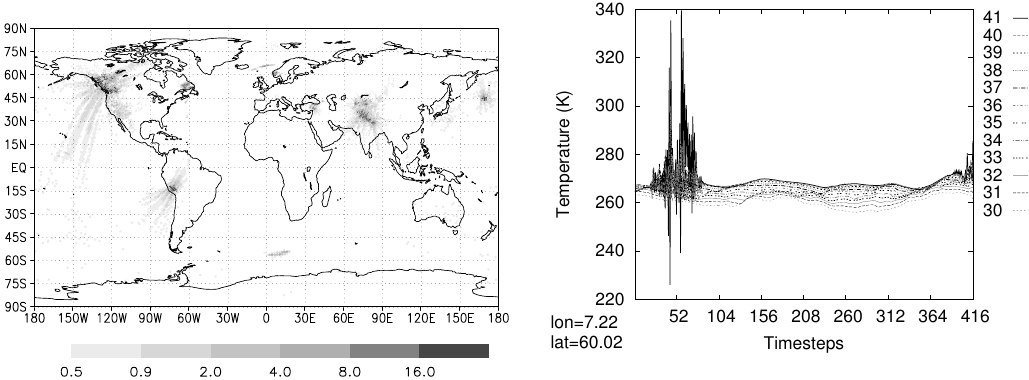
Fig. 12. The left figure shows the amplitude of 2∆ t temperature oscillations on the lowest model level (in Kelvin) after 96 hour forecast computed according to Equation 9 for the model run with the fibrillation amplifi- cation test of the large scale precipitation scheme but with evaporation ratio of ice and water reduced to 8. The figure on the right shows temperature (in Kelvin) in one model point on the 12 lowest model levels for each time-step during the 96 hour forecast for the model run with the fibrillation amplification test of the large scale precipitation scheme but with evaporation ratio of ice and water reduced to 8.